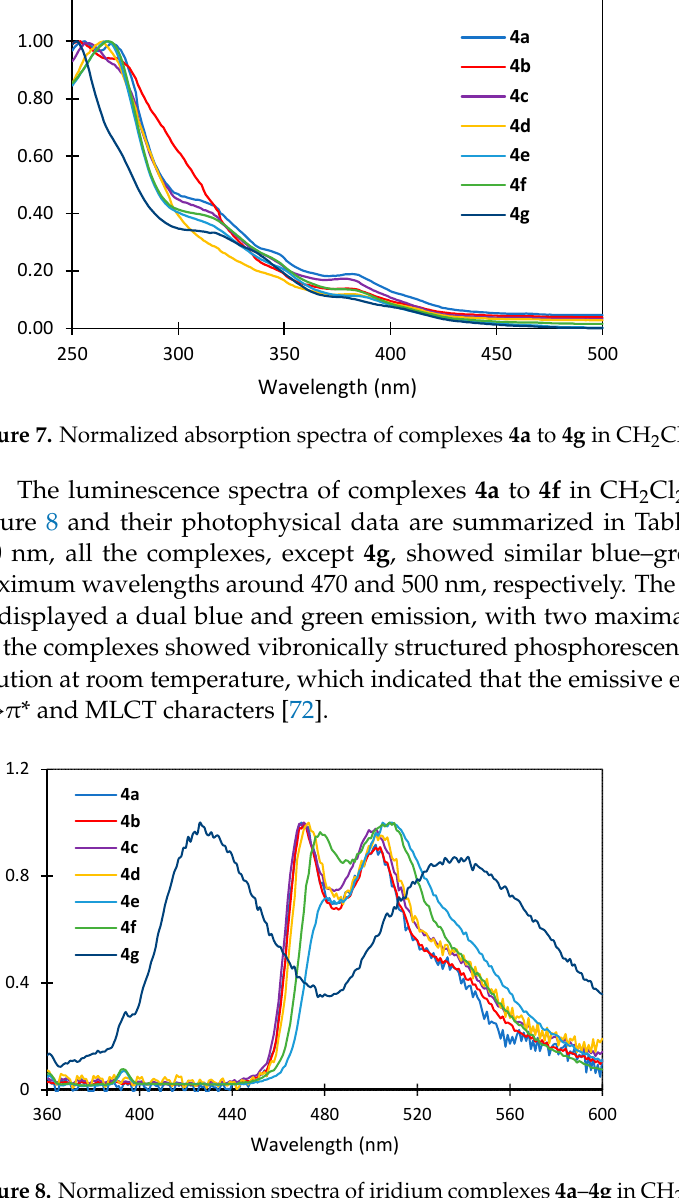
Figure 8. Normalized emission spectra of iridium complexes 4a – 4g in CH 2 Cl 2 at 298 K ( λ ex = 360 nm). Table 1. Photophysical data of iridium complexes 4a – 4g .